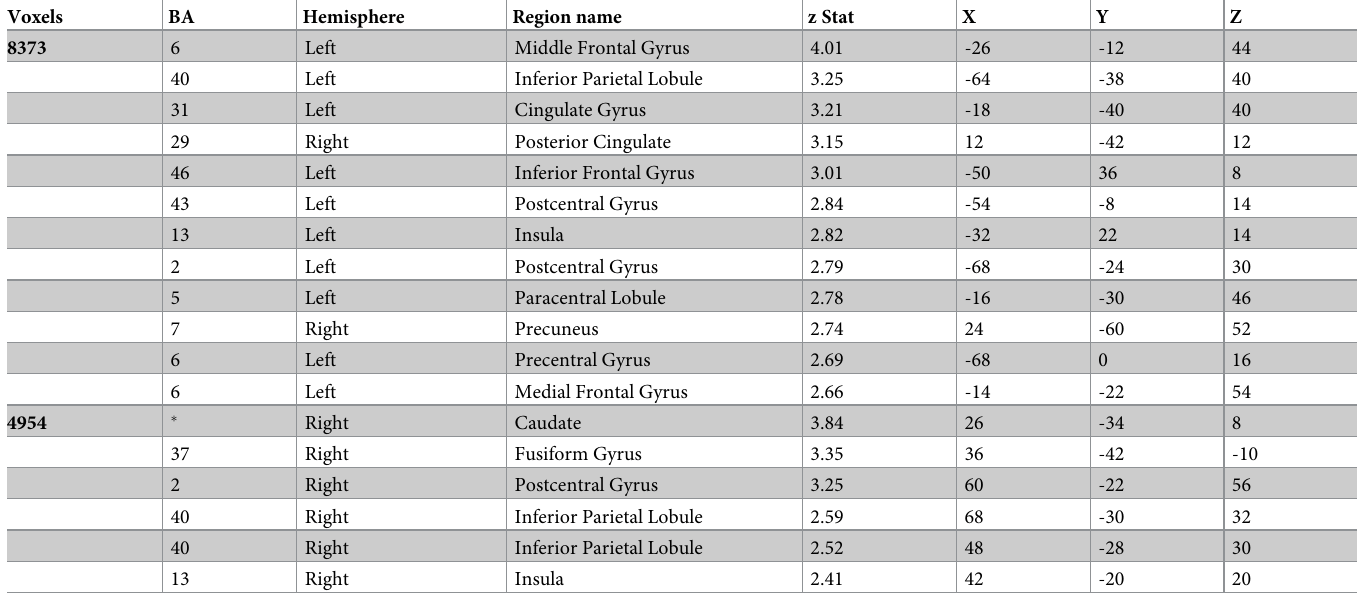
Table 6. Activation peaks of PPI